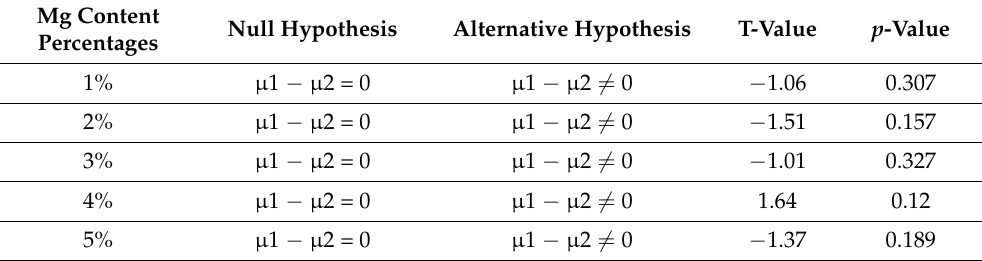
Table 5. The results of two-sample t-test for the hardness data.